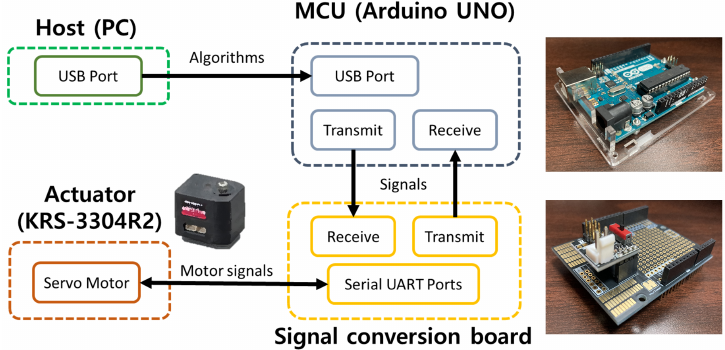
Figure 17. Diagram maps of the experimental system.